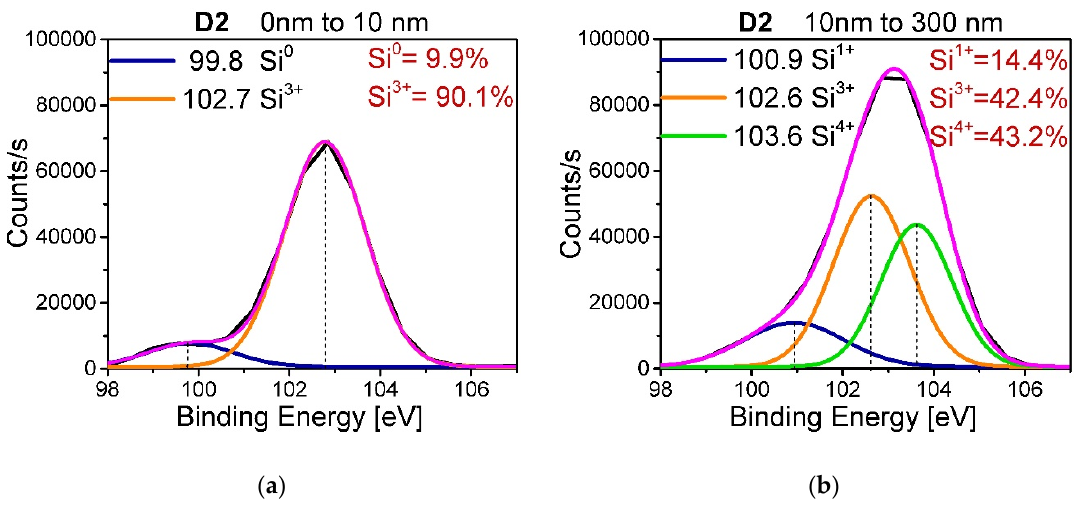
Figure 7. Deconvolution of the D2 film spectra obtained using XPS ( a ) for the region from 0 to 10 nm and ( b ) for the region from 10 to 300 nm.